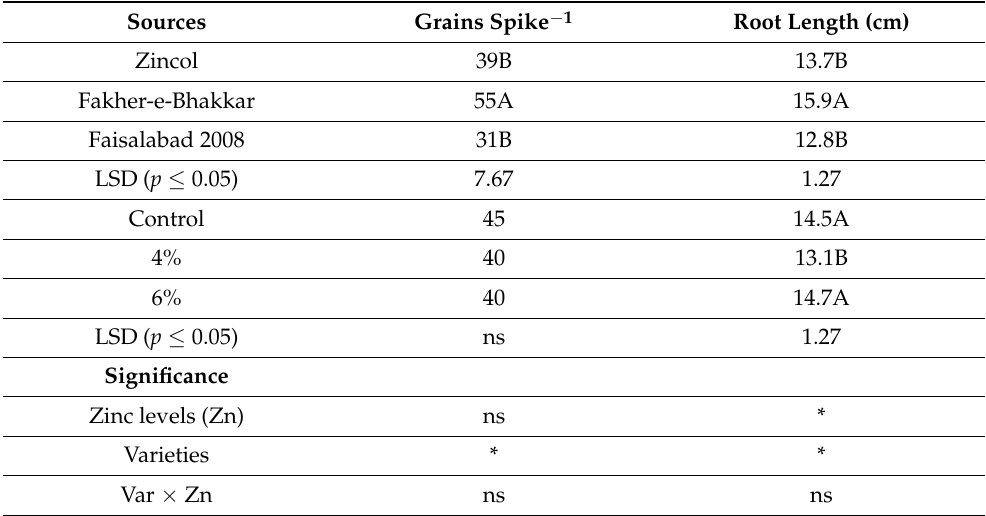
Table 2. Grain per spike and root length as affected by different foliar applied zinc and wheat varieties grown under controlled environment.